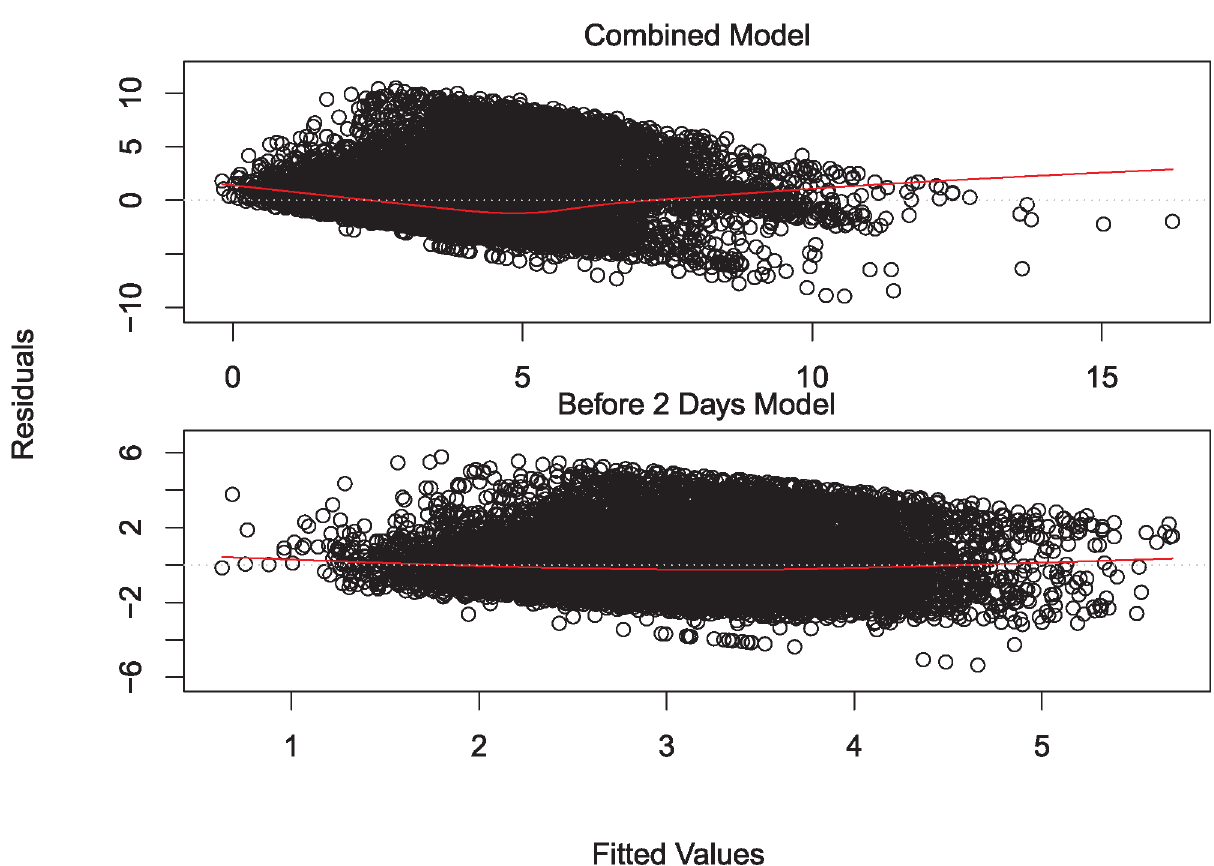
Fig 2. Residual vs. fitted value plots for combined and split time to answer models (lowess